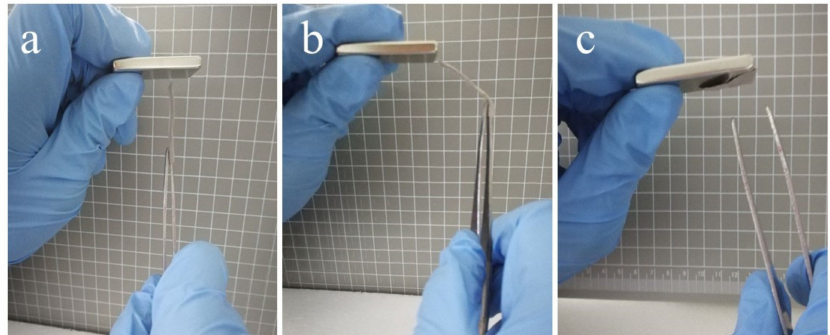
Figure 5. Flexibility and magnetic properties of PVP / γ -Fe 2 O 3 nanofibers fabricated by MES ( a ) directly under the magnet, ( b ) on the left of the magnet, and ( c ) released from the left of the magnet.